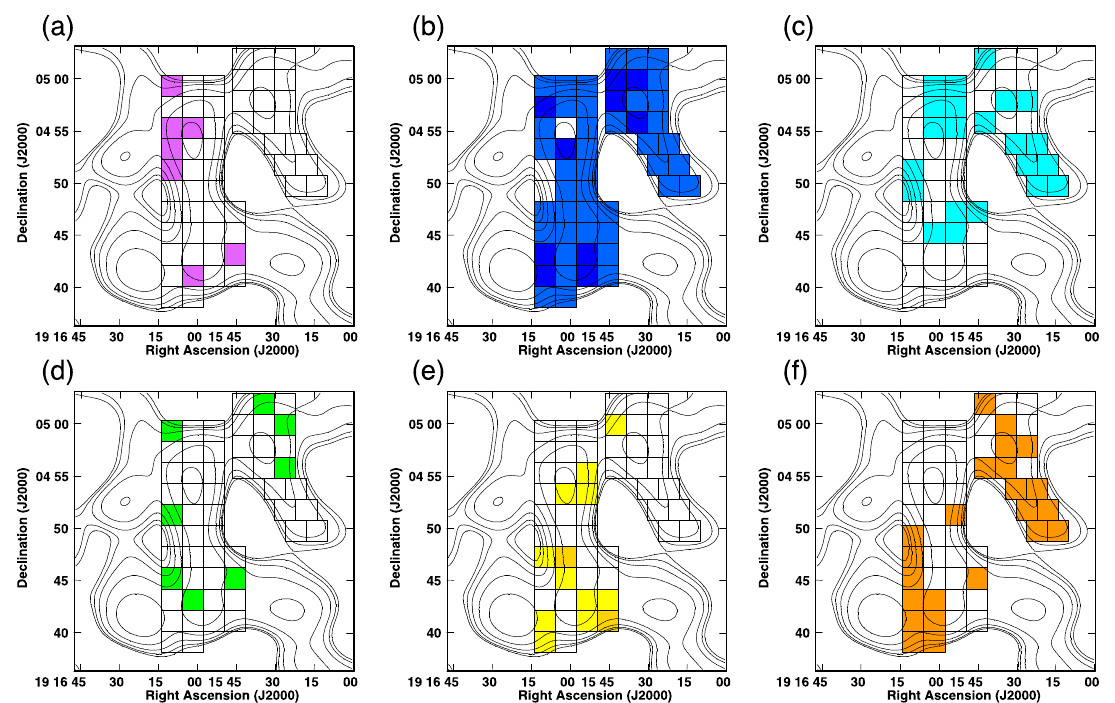
Figure 4. Spatial distribution of the Faraday Dispersion Function (FDF) components in the ( a ) purple ( ϕ = − 112 to − 57 rad m − 2 ), ( b ) blue ( ϕ = − 26 to 58 rad m − 2 ), ( c ) cyan ( ϕ = 59 to 143 rad m − 2 ), ( d ) green ( ϕ = 144 to 228 rad m − 2 ), ( e ) yellow ( ϕ = − 229 to 313 rad m − 2 ), and ( f ) orange ( ϕ = 314 to 398 rad m − 2 ) ranges of Faraday depth. In ( b , e ), there are deep colored pixels. There are two FDF components in these pixels.4. Discussion.